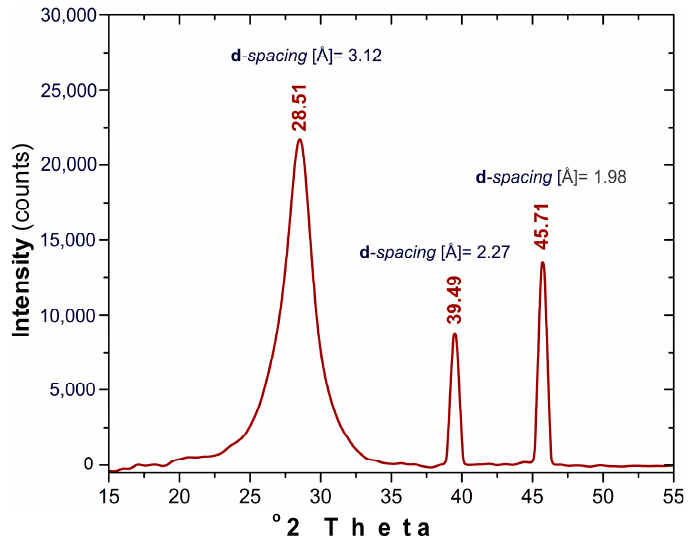
Figure 5. XRD pattern recorded for the prepared CDs.